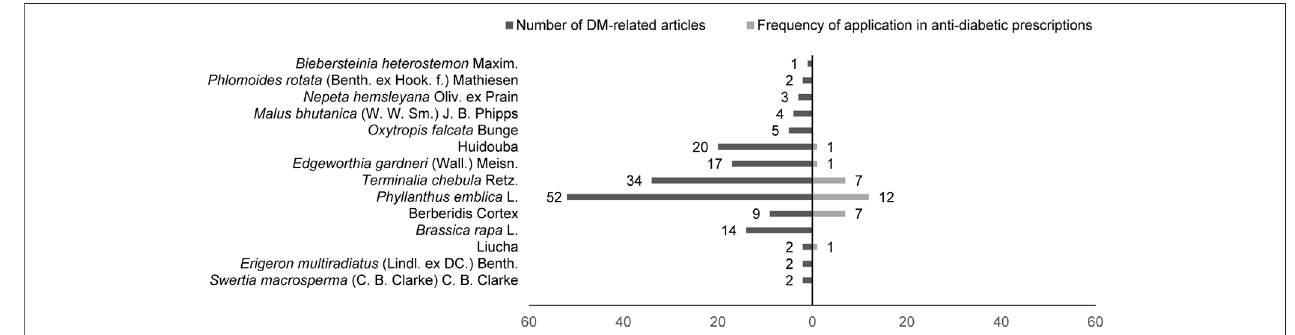
FIGURE 1 | Reported Tibetan medicinal plants/medicinal materials that are associated with DM treatment.